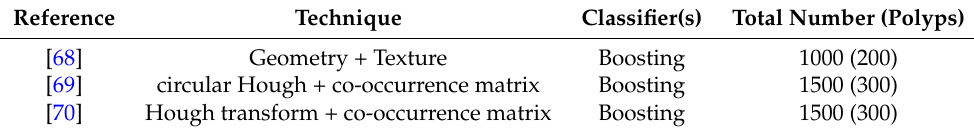
Table 3. Holistic polyp detection and segmentation approaches for endoscopy systems. Note that all of these proposed methodologies are so far only tested with traditional colonoscopy images